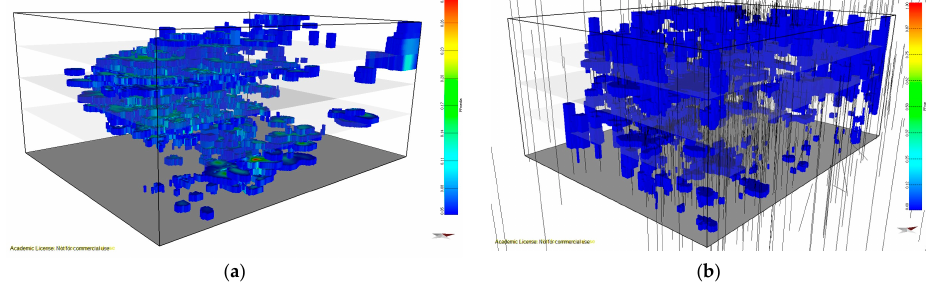
Figure 9. Final model 3D representation: ( a ) vein proportion (>5% of vein); ( b ) Coefficient of variation (<10% uncertainty). Grid 10 m × 10 m × 10 m.